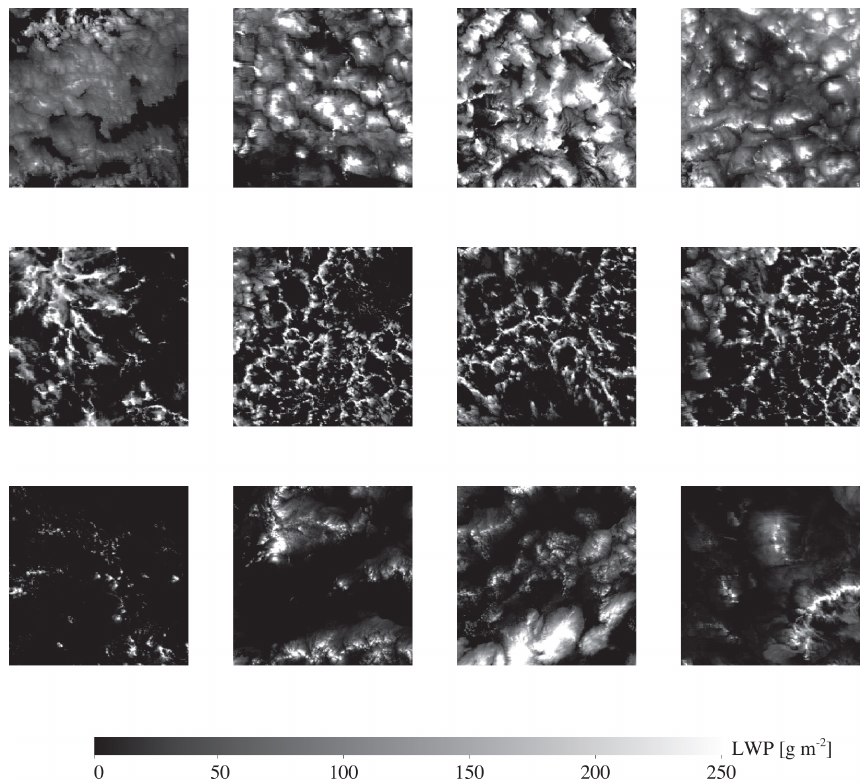
Figure 1. Example scenes of liquid water path (LWP) from MODIS Aqua for closed MCC (first row), open MCC (second row) and cellular but disorganized MCC (third row). Each scene spans an area of 256 × 256km 2 at 1km horizontal